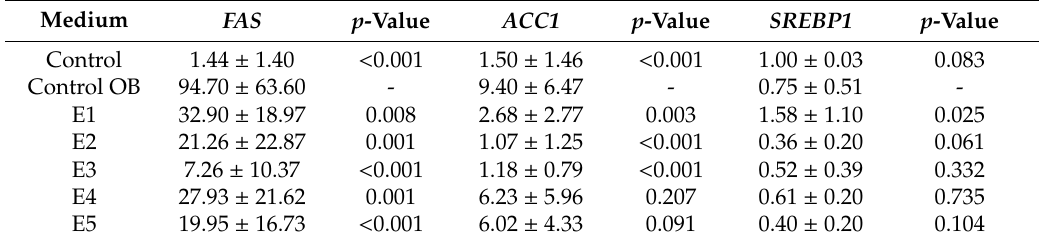
Table 2. Relative expression of lipogenic genes compared to the